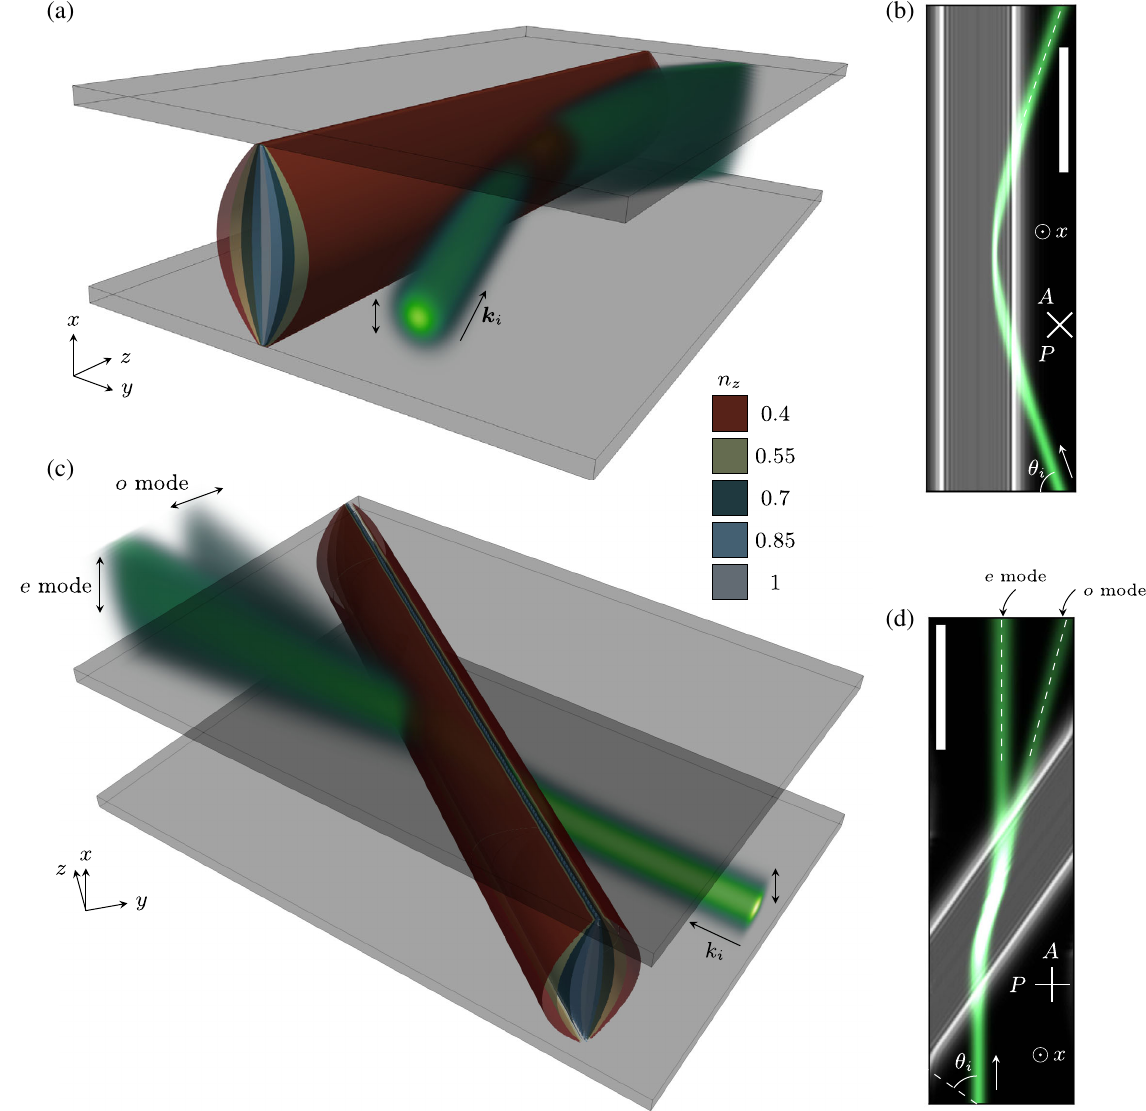
FIG. 4. (a) BPM simulation of a beam reflected by a twist wall. The green color corresponds to a 3D volumetric rendering of the optical field intensity. The colored surfaces correspond to isosurfaces of the z component of the LC director field. The beam profile is initially Gaussian but then spreads out along the x axis after interacting with the twist wall while confined between the two glass plates represented in gray. (b) Simulated microscope images of the system represented in (a), with the axis of observation along x . The POM image of the twist wall is simulated assuming crossed polarizers, and the green beam corresponds to the 3D volumetric data of (a) averaged along x . (c) Same as (a) with a different incident angle. Instead of a reflected mode, two transmitted modes associated with different polarizations are observed. (d) Same as (b) with the system of (c). The intensity of the o mode is enhanced 10 times in order to be seen with the naked eye. In (a),(c), the polarization state of light is represented with double arrows. In (b),(d), the white thick line represents 50 μ m; the white dashed lines represent the directions of propagation of transmitted or reflected beams predicted by Eq. (12) 70 ° for (a),(b) and θ 55 ° for assuming n ð α ;m Þ ≈ n α . The angle of beam incidence is θ i ¼ i ¼